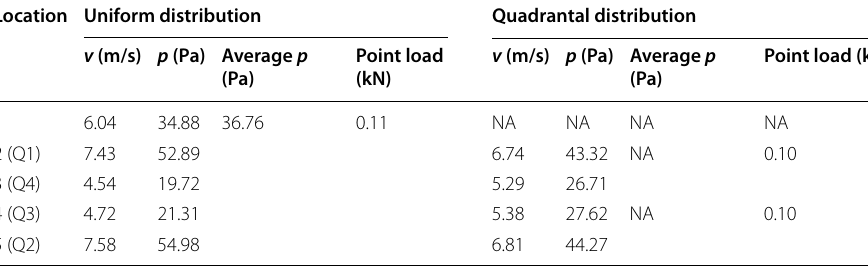
v wind velocity; p =